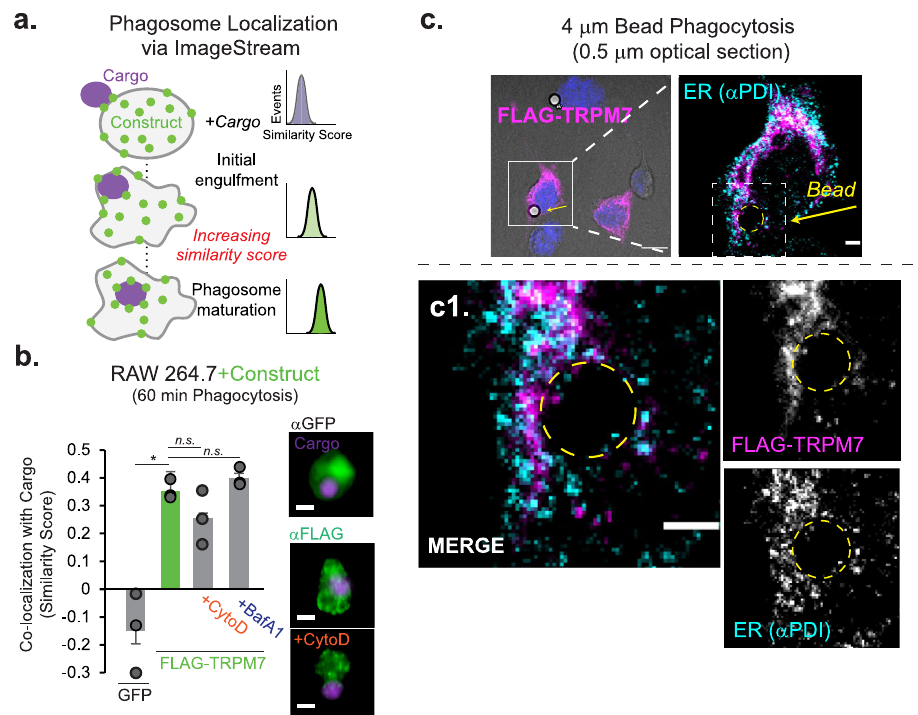
Fig. 6 TRPM7 localizes proximal to the nascent phagosome. a ImageStream-based analysis of protein localization in RAW 264.7 cells during phagocytosis of apoptotic cells is schematized. Similarity score measures colocalization of expression construct with CellTrace Violet-labelled cargo, and the score increases with increased colocalization. b ImageStream-based measurement of TRPM7 localization with phagocytosed apoptotic cells in fi xed RAW 264.7 cells. Either FLAG-TRPM7 or GFP was transfected 16 h prior to incubation with apoptotic cells. For controls, the cells were subjected to 15 min pretreatment with Cytochalasin D (Cyto D; 1 μ M) or Ba fi lomycin A1 (BafA1; 500 nM). After phagocytosis, the RAW 264.7 cells were fi xed and immunostained for FLAG immunoepitope. Fluorescence of GFP and anti-FLAG was measured via ImageStream fl ow cytometry. Bar charts represent mean of n = 3 independent samples and the individual data points are overlayed; error bars are SEM. Representative cells are shown at right. Representative results of two independent experiments are shown. * p = 0.035. See also Supplementary Fig. 4a – c. c Confocal immuno fl uorescence microscopy of FLAG- TRPM7-expressing LR73 phagocytes after addition of 4 μ m beads for phagocytosis. Fixed cells were immunostained for FLAG (TRPM7-green) and fl uorescent beads (red). Top left: Bright fi eld shown merged with FLAG (magenta) and nuclei (blue); scale bar = 10 μ m. Top right: merged ROI of FLAG and ER marker (PDI). Bottom left [ c1 ]: FLAG-TRPM7 and PDI light are shown with merged pseudocolored image; scale bar = 3 μ m. Bottom right: Single-channel images shown at bottom left. White dash box indicates ROI, and yellow dashed circled shows bead-containing phagosome. Single optical sections (0.5 μ m) are shown. Additional single-channel images shown in Supplementary Figs. 4d, e and 5a. Source data are provided as a Source Data fi le, and statistical testing is described in “ Statistics and Reproducibility ” signi fi cantly, resulting in at least a 40% decrease in acidi fi cation across all time points (Fig. 7a). Although the role of the kinase activity of TRPM7 in phagosome maturation cannot be ruled out, the sensitivity of phagosome maturation to the TRPM7 channel blocker (FTY720) argues that the channel activity plays an important role in the regulation of phagosome maturation. At